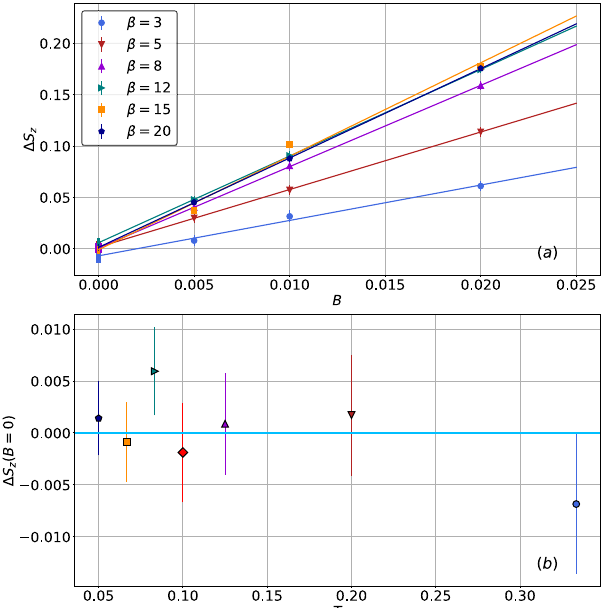
15. (a) Linear extrapolations for the induced SDW order Δ